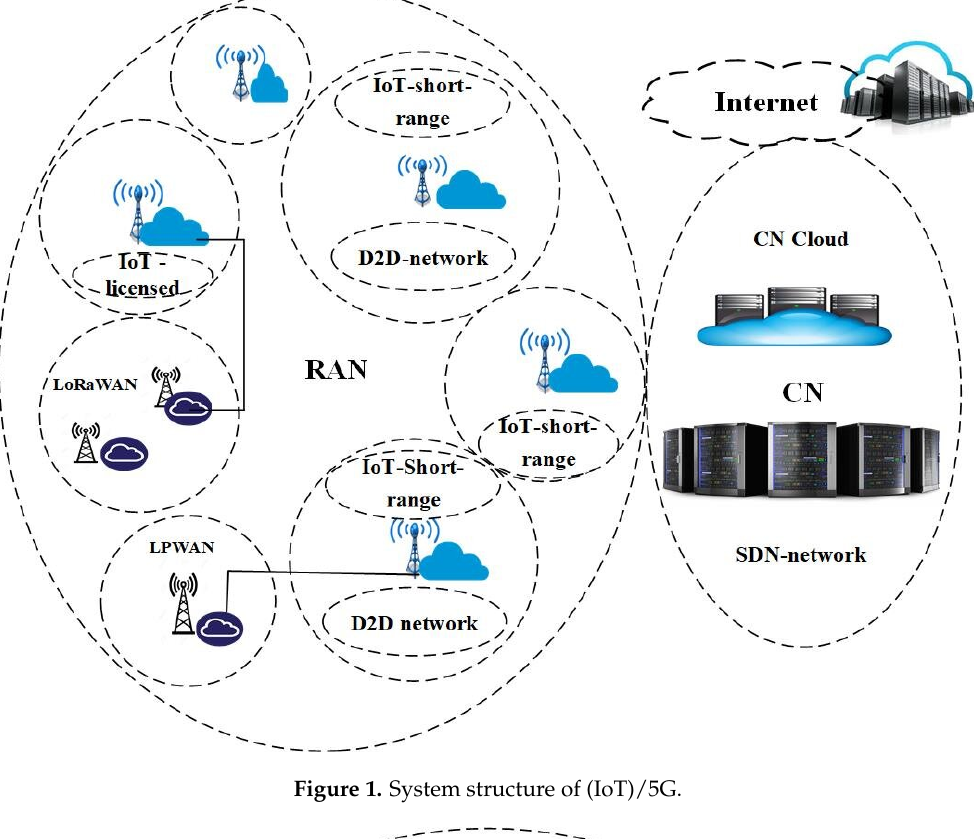
Figure 1. System structure of (IoT)/5G.